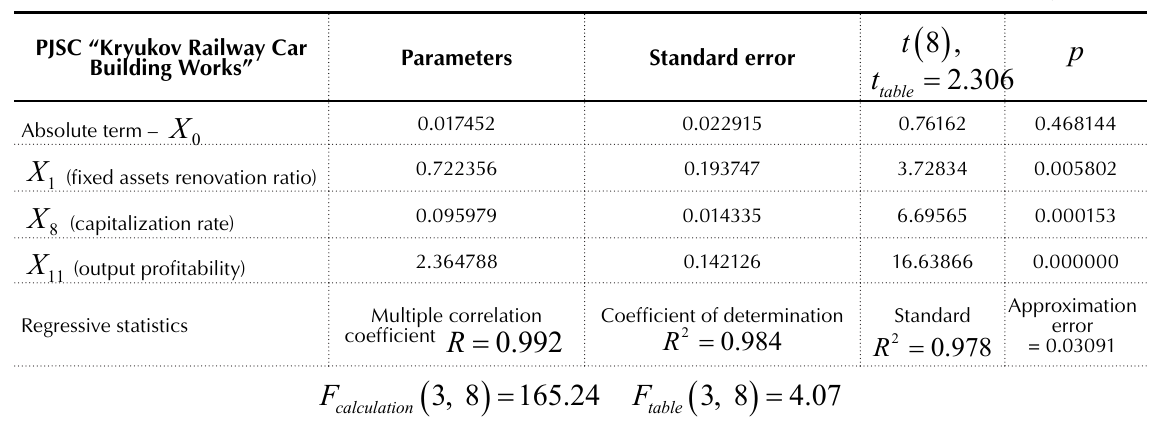
Table 2. Correlation and regression model of the internal capacity of technology transfer system development at PJSC “Kryukov Railway Car Building